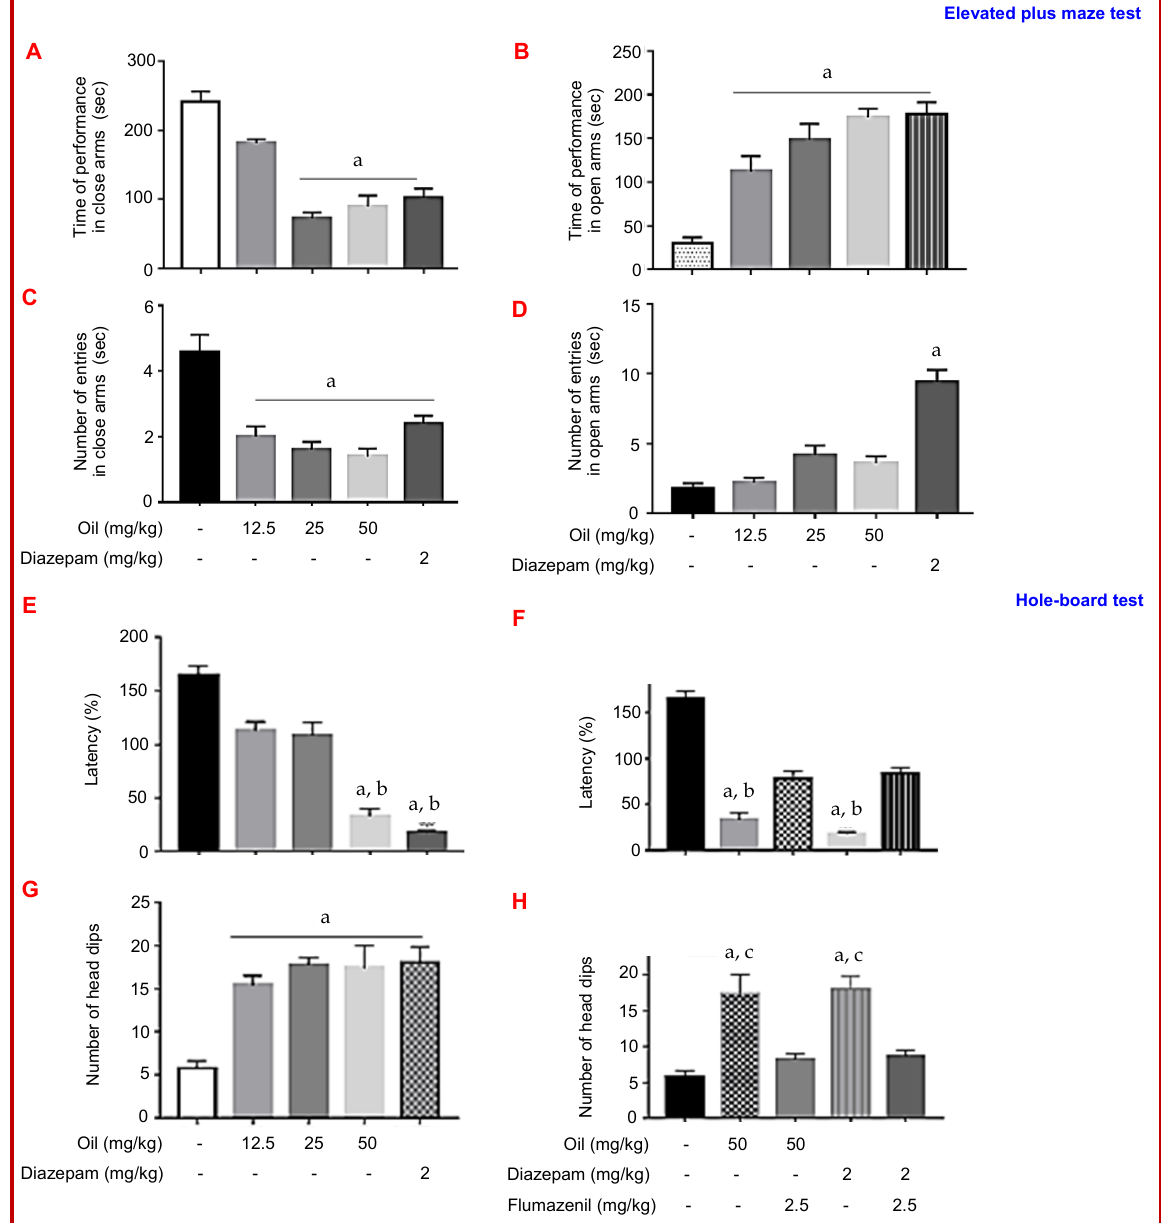
Figure 3: Effect of P. lentiscus essential oil in elevated plus maze test (A-D) and hole-board test (E-H) in mice (n=6 in each group). The results are expressed as mean ± SEM, “a” indicate significant difference between control group and treated groups. done according to ANOVA one way followed by Kruskal Wallis/Tukey’s